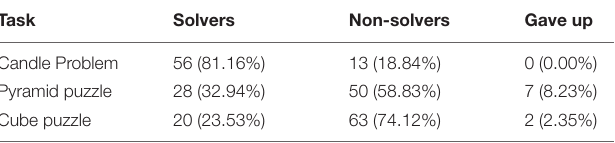
TABLE 2 | Solvers and non-solvers for each type of problem in Tasks III and IV.